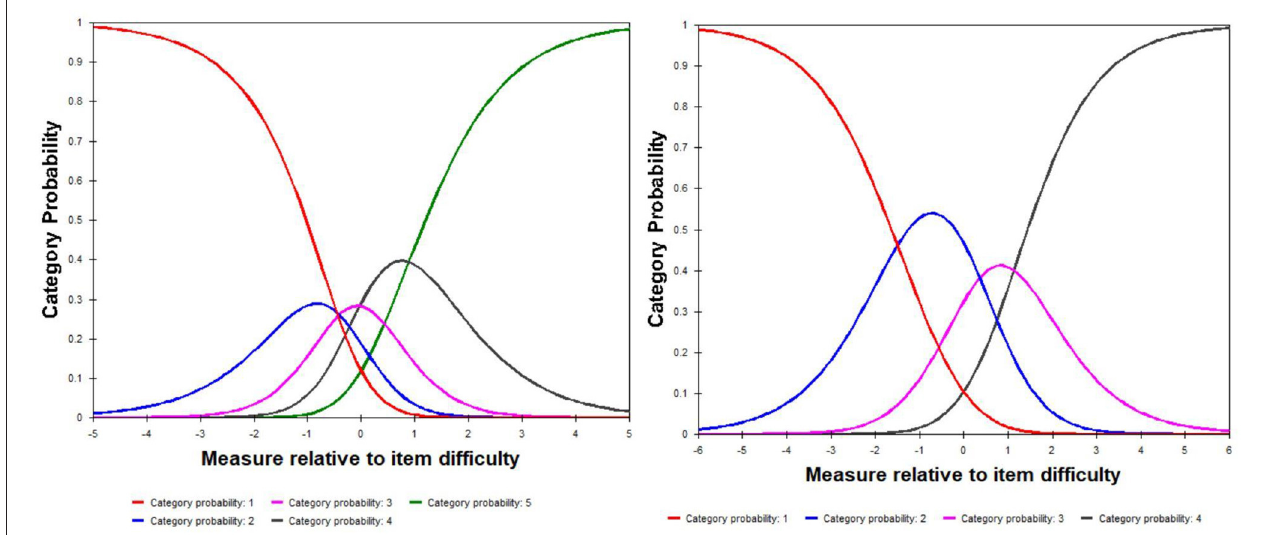
FIGURE 1 | Category probability curves of item 2. The left figure was drawn based on the original five-point response categories (never = 1, rarely = 2, sometimes = 3, often = 4, always = 5); the right figure was drawn after merged the original category 2 (rarely) and 3 (sometimes), namely, the new response categories were 1 = never, 2 = rarely/sometimes, 3 = often, 4 = always.